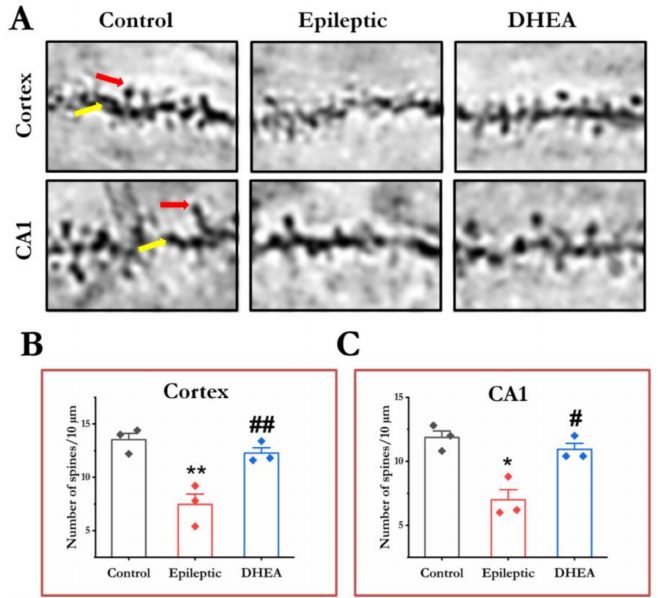
Figure 6. Morphological analysis of dendritic spines in the cortex and hippocampus of control, epileptic and DHEA-treated rats. Representative photomicrographs of Golgi-Cox-stained neurons